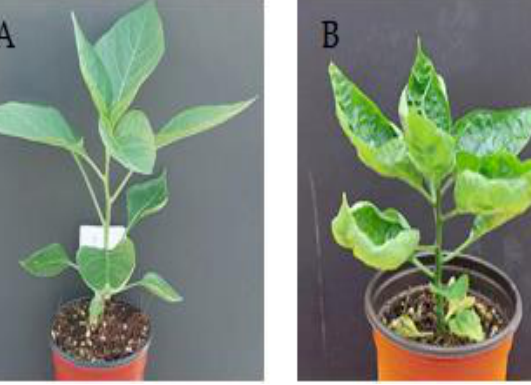
Figure 3. Features of healthy and PMMoV-infected pepper plants. ( A ) Uninfected plant. ( B ) PMMoV-infected plant with mottled leaves. ( C ) PMMoV-infected plant with chlorotic leaves. ( D ) Fruit showing typical symptoms of PMMoVinfection (e.g., blistered and lumpy).